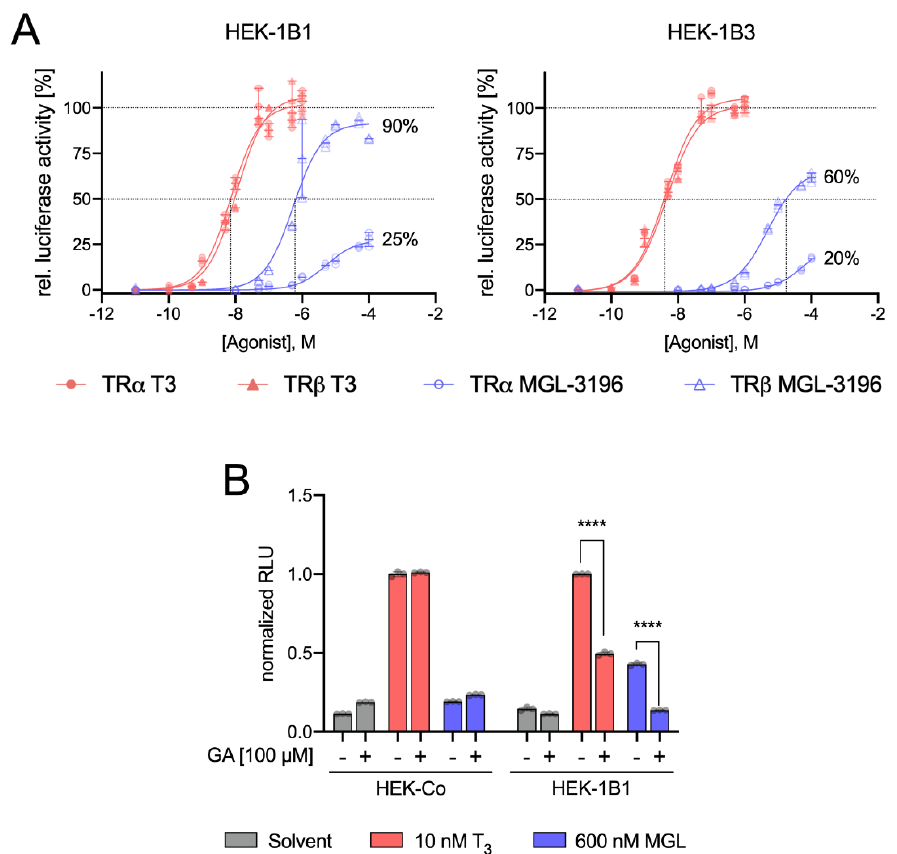
Figure 3. Dose-response curve and luciferase activity: ( A ) EC 50 values were determined by DR4 luciferase reporter assay in cells stably expressing OATP1B1 or OATP1B3 (HEK-1B1 and HEK-1B3, respectively). Additionally, the cells were transfected with plasmids either encoding for TR α (circles) or TR β (triangles). Cells were cultured in TH-depleted serum and treated with T 3 (0.1–1000 nM; red-filled triangles or circles) or MGL-3196 (10–10,000 nM; blue open triangles or circles) for 48 h; ( B ) inhibition of OATP1B1-dependent uptake of MGL-3196 was determined in a DR4 luciferase reporter assay with HEK-Co (control) cells and HEK-1B1 cells (stably expressing OATP1B1) and 100 µ M GA (glycyrrhizinic acid) as OATP1B1 inhibitor. RLU in T 3 -treated cells without GA = 1.00 in each cell line. Two-way ANOVA with Tukey’s post hoc test: **** p < 0.0001.